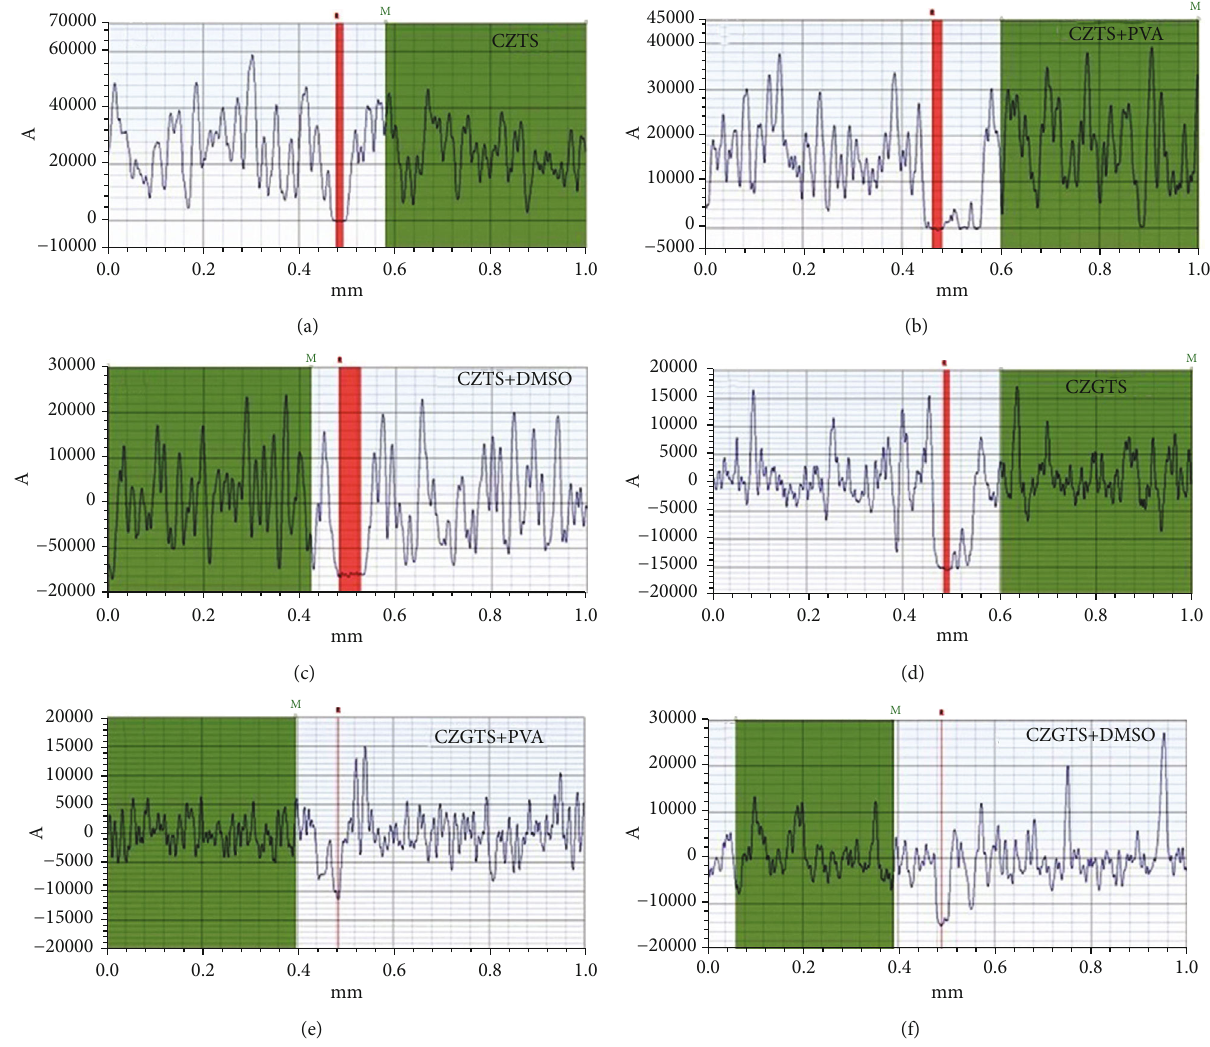
Figure 2: (a – c) CZTS, CZTS-PVA, and CZTS-DMSO; (d – f) CZGTS, CZGTS-PVA, and CZGTS-DMSO thickness pro fi llometer